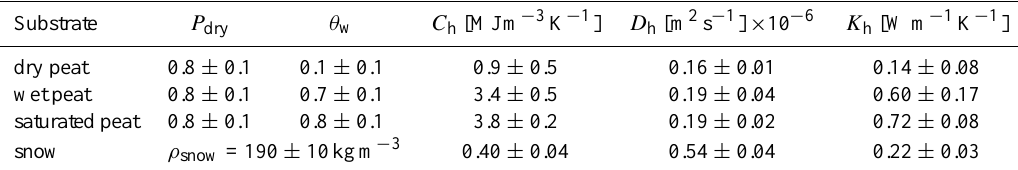
Table 1. Used soil and snow parameters for ground-heat flux calculations. Values of porosity P dry and water content θ w are inferred from soil sample analysis and measurements of in-situ soil water content . The heat capacities are calculated by weighting C h , w and C h , s according to water content and porosity. The thermal diffusivities D h are determined using the conductive method (see Sect. 3.3.2), from which we obtain the thermal conductivities K h in conjunction with the assumed heat capacity. The given uncertainties account for spatial variabilities of C h , D h , and K h within the different soil